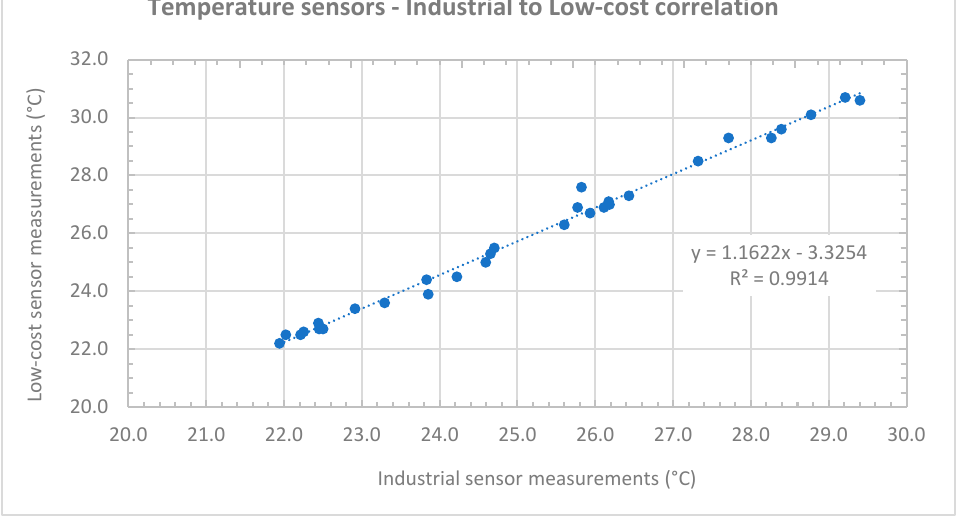
Figure 6. Correlation of industrial and low ‐ cost temperature sensors’ measurements.